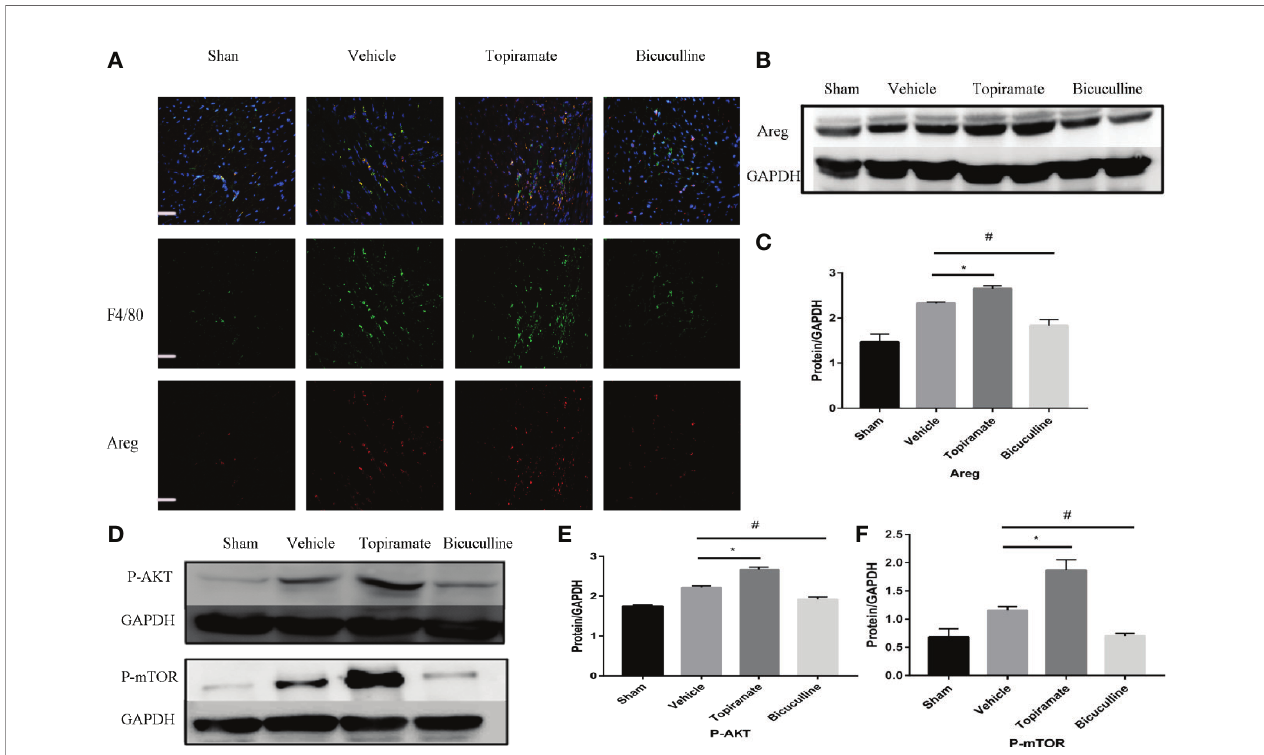
FIGURE 5 | Areg expression and Akt/mTOR signaling are involved in the GABA A receptor-mediated cardiac hypertrophy. (A) Representative micrographs showing immuno fl uorescent staining of Areg (red) and a macrophage marker, F4/80 (green) in a sample of heart tissue. Nuclei were counterstained with DAPI (blue). Scale bar = 50 µm. (B) Representative images of Areg protein at day 7 post-TAC in heart. (D) Representative images of P-Akt and P-mTOR protein at day 7 post-TAC in heart. (C, E, F) Quantitative analysis of Areg protein (C) , P-Akt protein (E) , and P-mTOR protein (F) at day 7 post-TAC in heart. GAPDH mAb (middle) was used as a loading control. Data are mean ± SEM, by one-way ANOVA with Bonferroni ’ s multiple comparison test. For topiramate treatment, *P < 0.05 vs. vehicle. For bicuculline treatment, # P < 0.05 vs. vehicle. (each group, n =